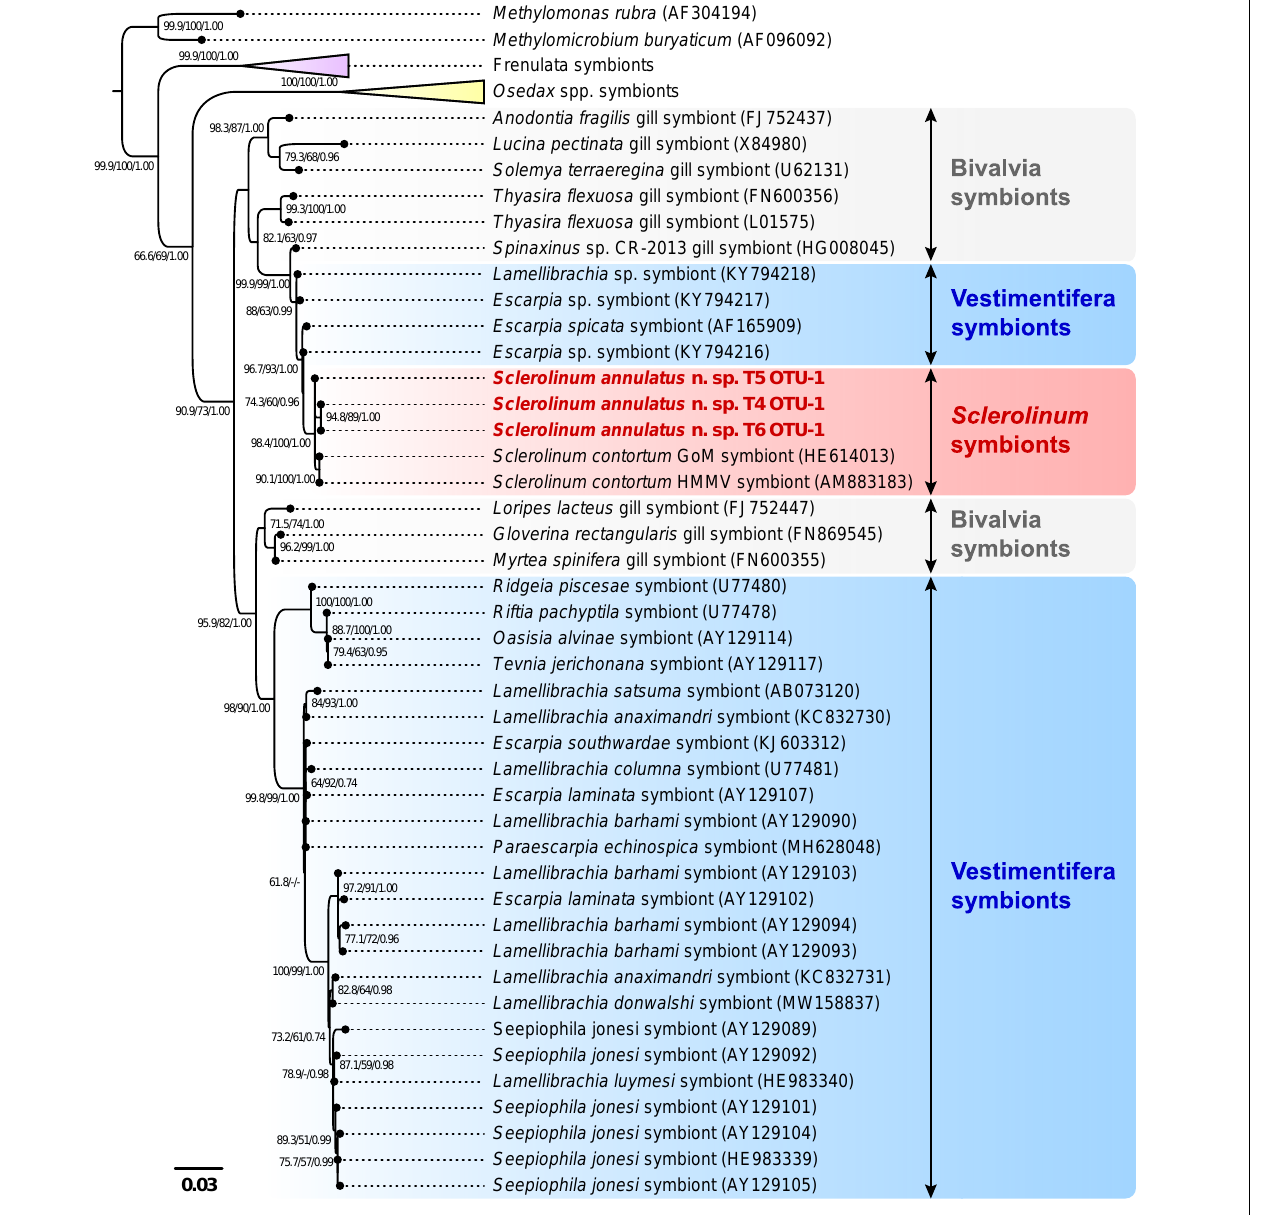
that of S . contortum having been characterized (Pimenov et